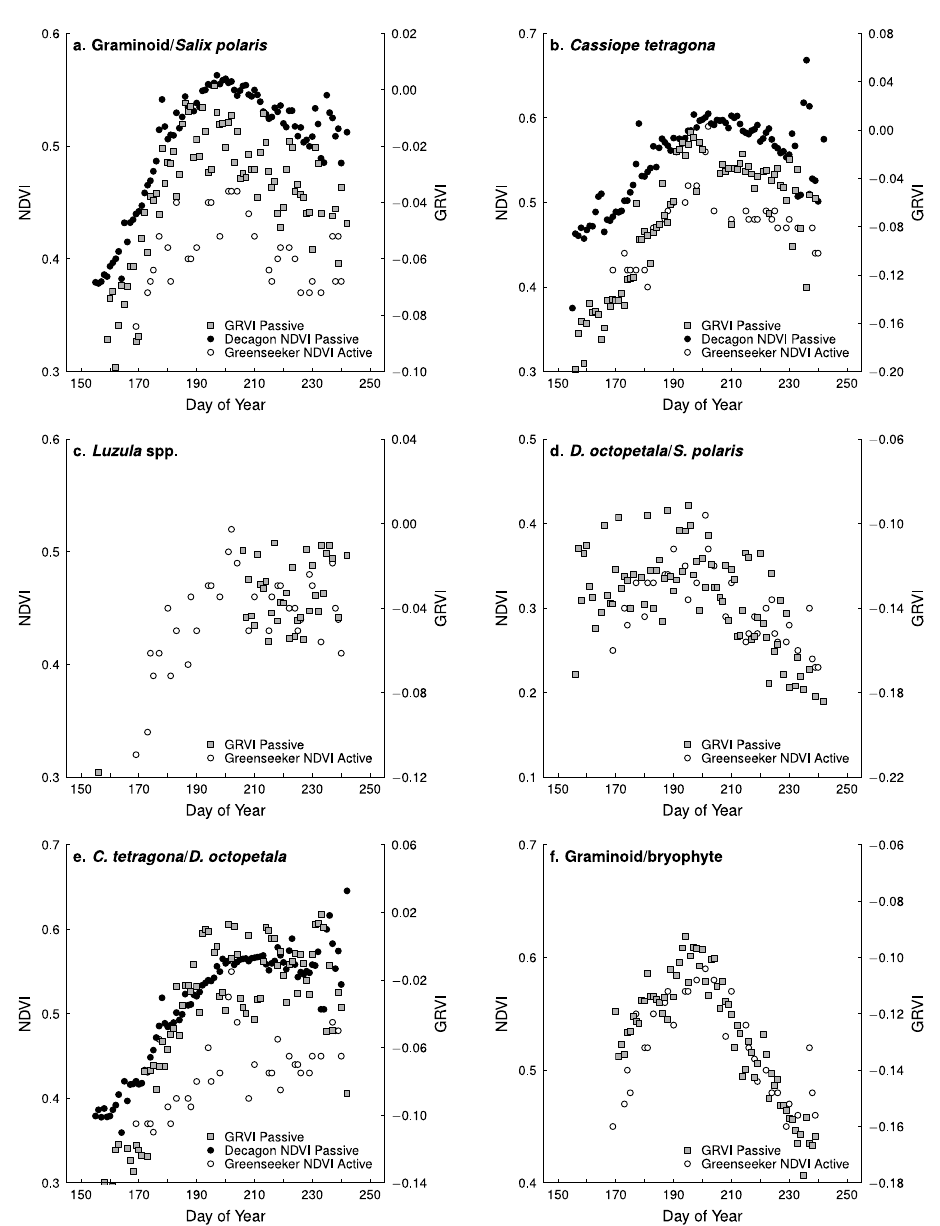
Figure 2. NDVI and greenness index values from six different High Arctic plant communities throughout the growing season. Readings were taken between 5 June (day of year = 156) and 30 August (day of year = 242) 2015 in: ( a ) Graminoid/ Salix polaris ; ( b ) Cassiope tetragona ; ( c ) Luzula spp.; ( d ) Dryas octopetala / Salix polaris ; ( e ) Cassiope tetragona / Dryas octopetala ; and ( f ) Graminoid/bryophyte vegetation. NDVI was recorded using Decagon surface reflectance sensors (black circles) and a Trimble Greenseeker handheld sensor (open circles); the Green-Red Vegetation Index (GRVI) values (grey squares) were calculated from red and green channel data from RGB images.